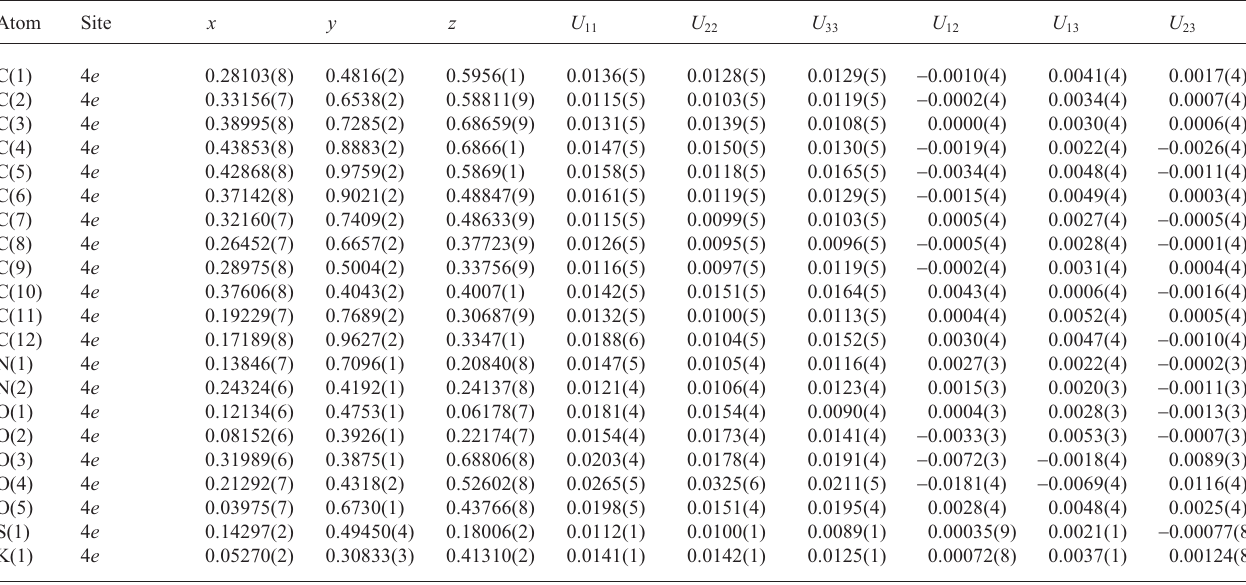
Table 3. Atomic coordinates and displacement parameters (in Å 2 )